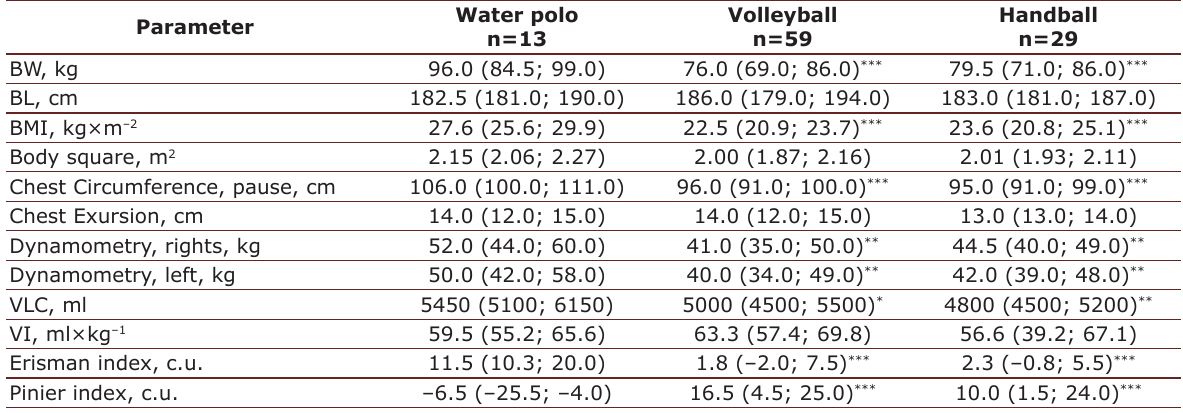
Table 1. Average parameters of athletes’ physical development of various game sports, M (25; 75)